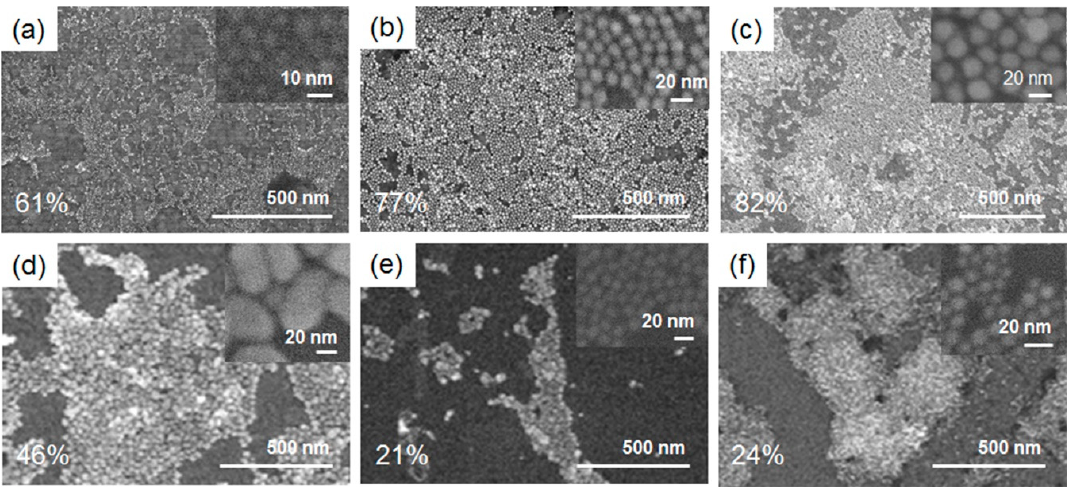
Figure 2. SEM images of the ( a ) 5Dod-array , ( b ) 10Dod-array , ( c ) 20Dod-array , ( d ) 40Dod-array , ( e ) 10Dod-array/Cr , and ( f ) 10Dod-array/ indium tin oxide (ITO) . Inset shows magnified SEM images.